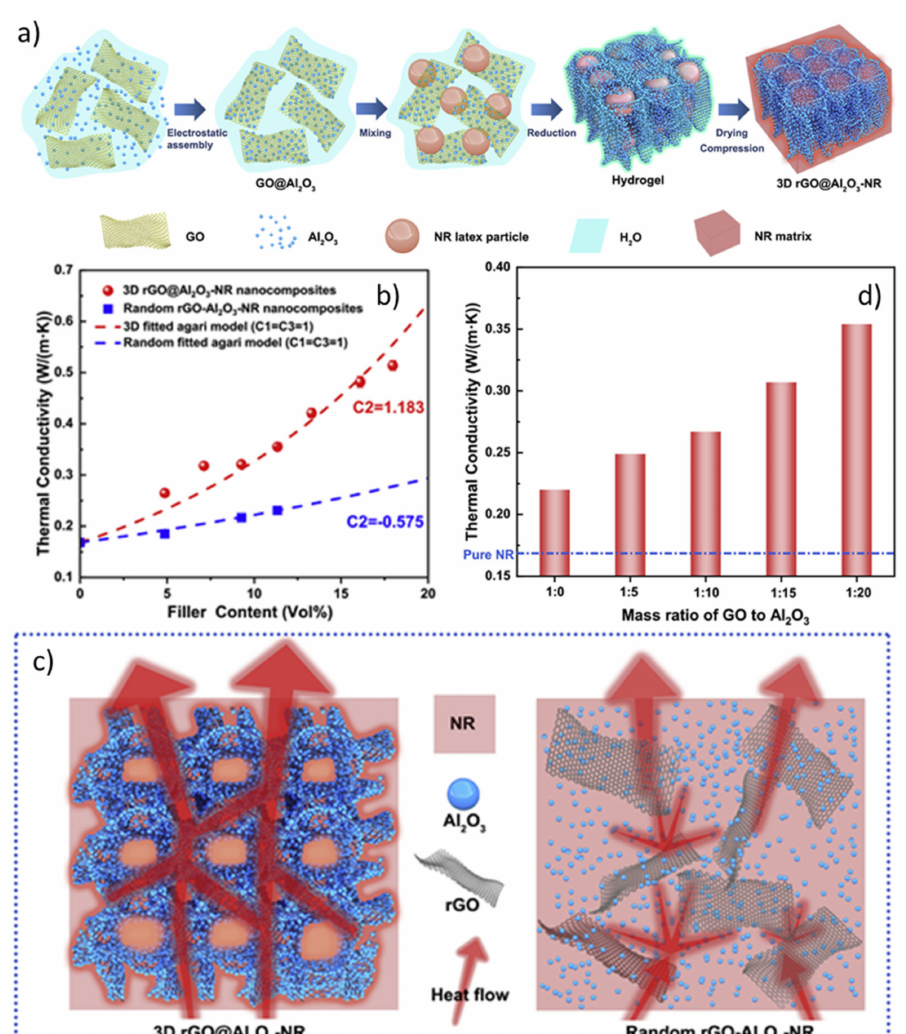
Figure 21. ( a ) Scheme of the procedure for the fabrication of 3D rGO@Al 2 O 3 -NR nanocompos- ites; ( b ) Trend of the thermal conductivity for 3D rGO@Al 2 O 3 -NR and Random rGO-Al 2 O 3